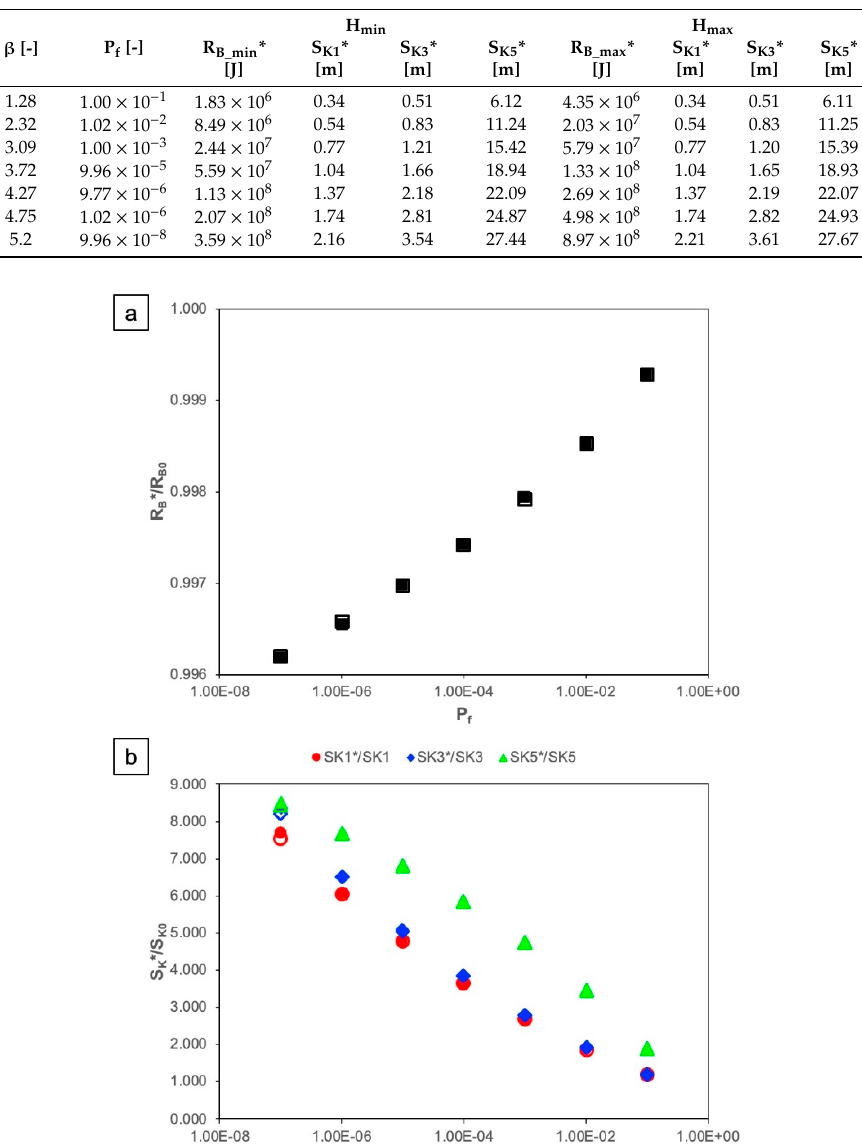
Figure 5. ( a ) Ratio between the design parameter (R B * and S K *) and mean value for resistance (R B0 and S K0 ) and ( b ) for set spacing as a function of the probability of failure. All the parameters are dimensionless.